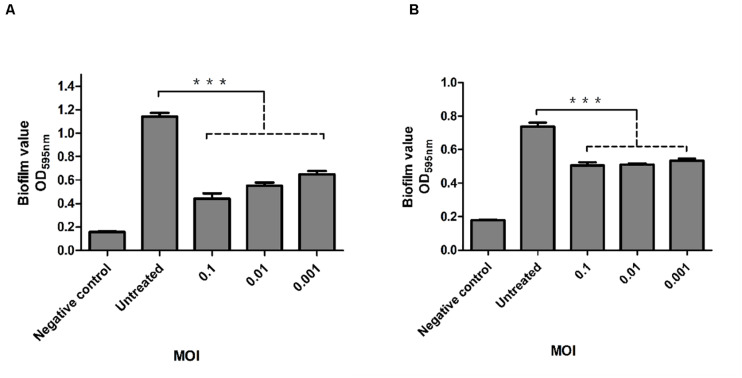
Antibacterial and antibiofilm activity of phage P545. (A) P545 inhibited the formation of biofilms. P545 was incubated with CRKP strain KP4 at MOIs of 0.1, 0.01, and 0.001 in 96-well plates for 24 h. (B) P545 disrupted the mature biofilm of KP4. Biofilm formation of KP4 was induced in 96-well plates for 24 h, and then the biofilm was treated with P545 at MOIs of 0.1, 0.01, and 0.001 for 24 h. Fresh TSB medium was used as a negative control. The OD595 values of the residual biofilms were measured after crystal violet staining. All the data are shown as the mean ± SEM. ***indicates p < 0.001.